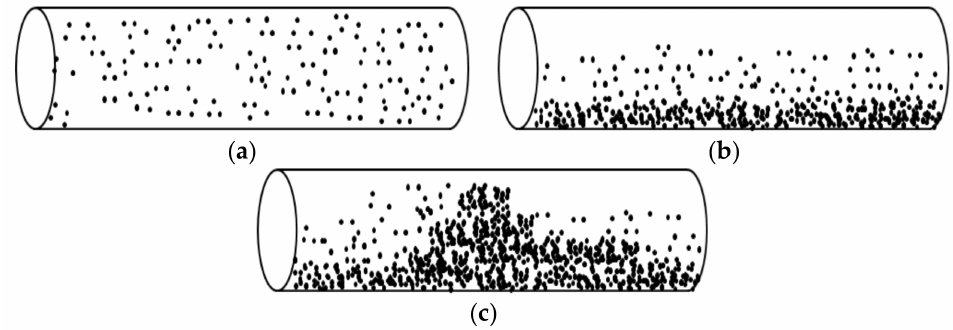
Figure 1. Horizontal pneumatic transport. ( a ) Homogeneous flow; ( b ) Dune flow; ( c ) Slug